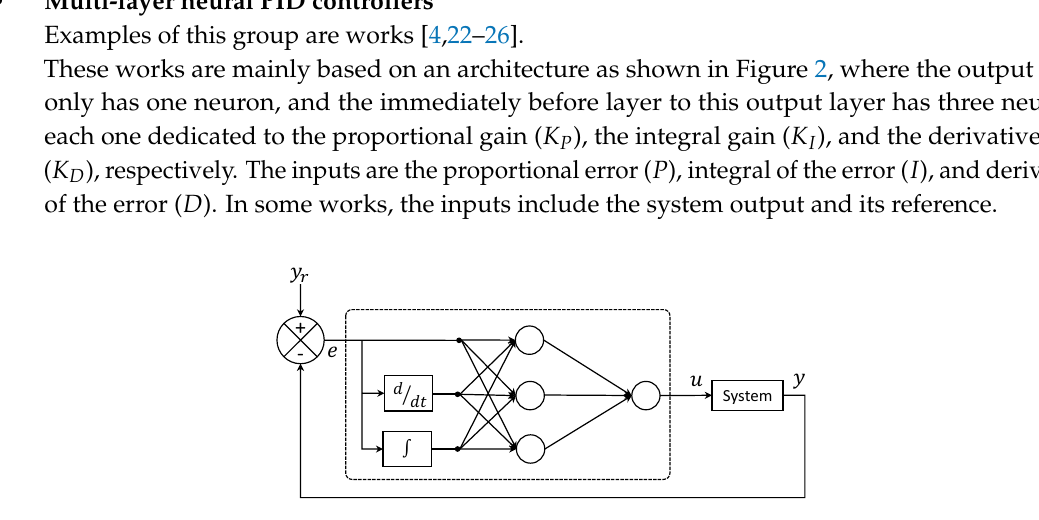
Figure 2. Multilayer PID controller scheme.